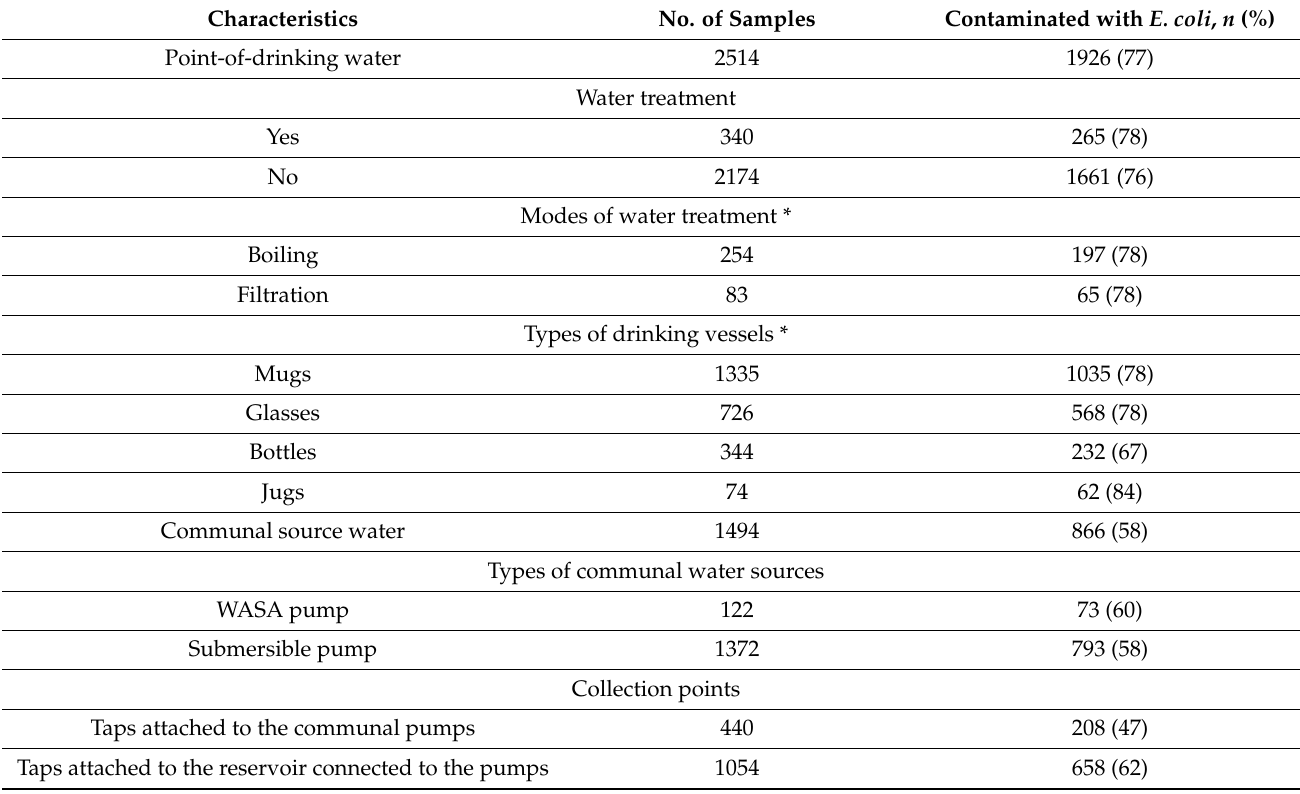
Table 1. The presence of E. coli in point-of-drinking water and communal source water of the study households, stratified by various